Question: Judging by this figure, is the value going up or going down?
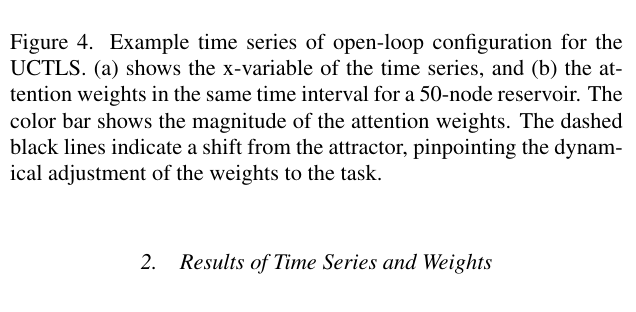
Answer: increasing